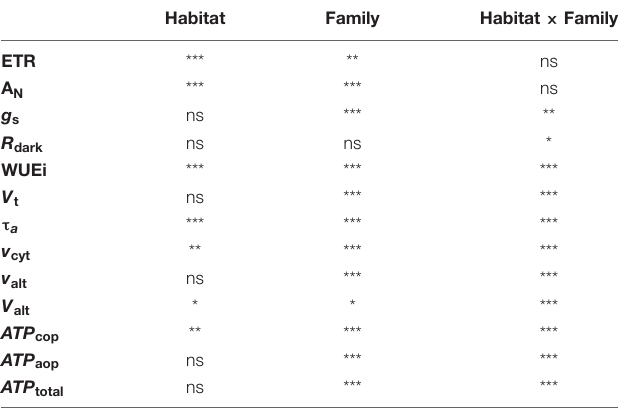
TABLE 2 | Significance of sources of variation after two-way analysis of variance analyses for each parameter.